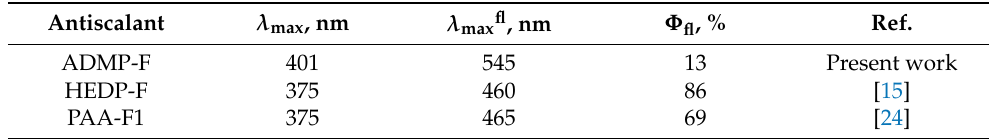
Table 1. Absorption and emission of fluorescent-tagged antiscalants 1 . Antiscalant λ max , nm λ maxfl , nm Φ fl , % Ref. ADMP-F 401